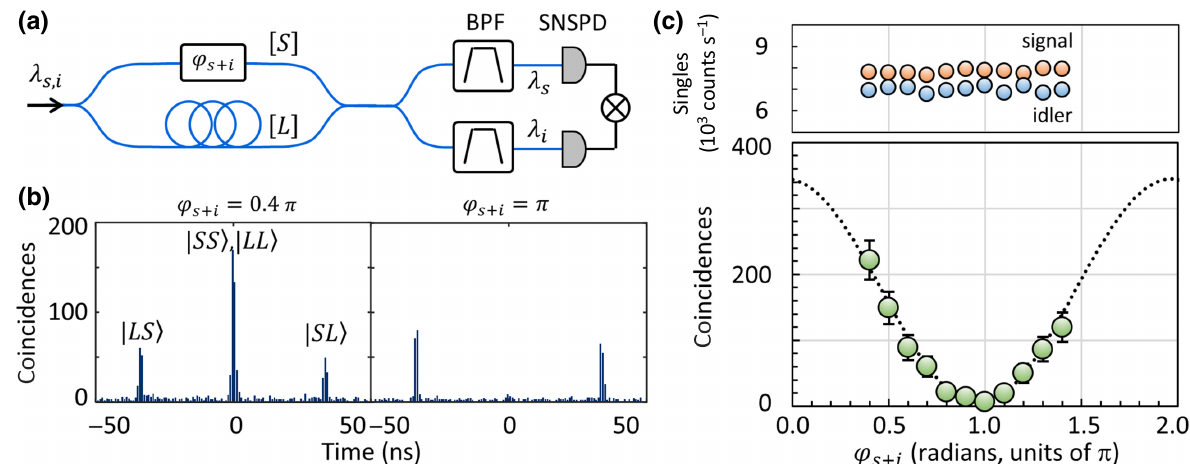
FIG. 4. (a) A schematic illustration of the setup for the two-photon interference experiment using a fiber-based folded Franson inter- ferometer: BPF, band-pass filter; [S] ([L]), short (long) interferometer path; SNSPD, superconducting-nanowire single-photon detector. (b) Coincidence histograms for different interferometric phase φ s + i = 0.4 π and π , respectively.(c) Singles counts (top) measured with the interferometer setup simultaneously with the two-photon interference (bottom). The visibility of the raw (fitted) data yields 95%